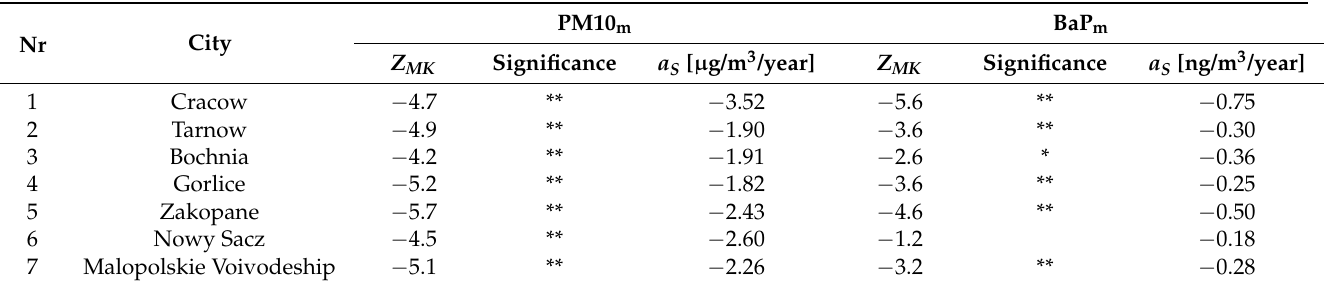
Table 5. Trends in average monthly concentrations of PM10 m and BaP m (PM10) in 2011–2020 (for